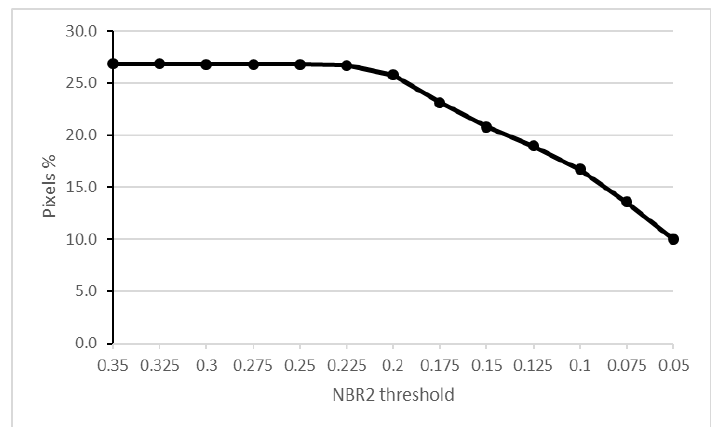
Figure 7. Percentage of the selected pixels of the Sentinel-2 image for different normalized burn ratio 2 (NBR2) thresholds. Table 2. Descriptive statistics of the validation datasets retrieved from the GASI+Demmin dataset after the use of different Normalized Burn Ratio2 index (NBR2) thresholds and the corresponding root mean square error (RMSE) and ratio of performance to deviation (RPD) of validation. RE-CI: Red-Edge Carbon Index; RRE-CI: Red-Red-Edge Carbon Index.